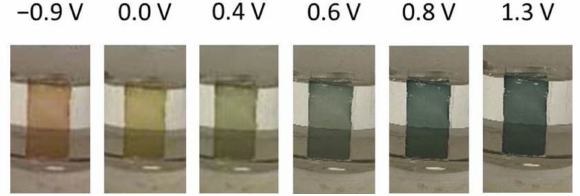
Figure 10. The color change of the poly-[NiAmben] film with varying